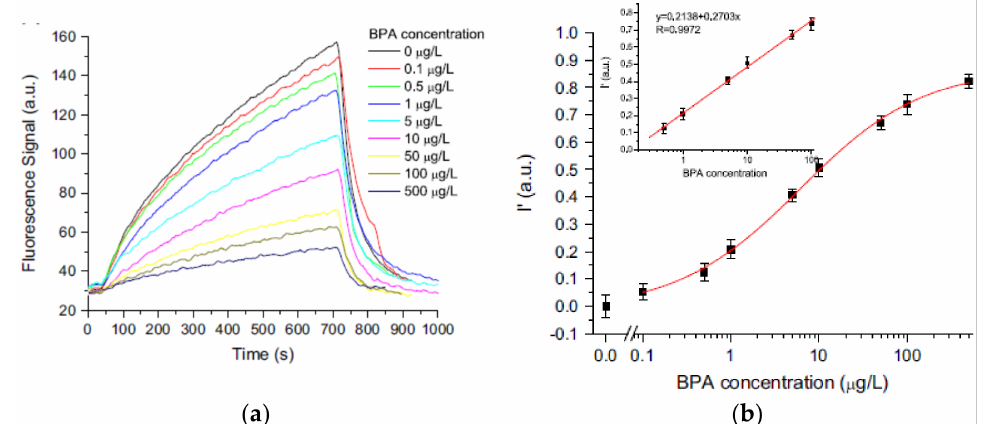
Figure 13. ( a ) Typical fluorescence curves signals obtained at various concentrations of BPA. ( b ) Logarithmic calibration curves for determination of BPA obtained by using an optofluidics-based immunosensor. In the inset, the linear relationship between BPA concentration and fluorescence intensity is shown. (Reprinted-adapted-with permission from